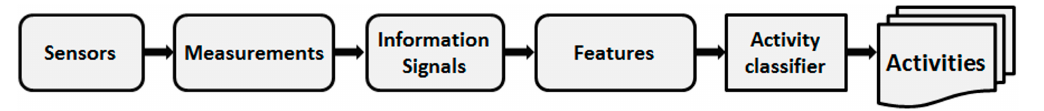
Figure 2. The process of motion state recognition from sensor measurements to recognized